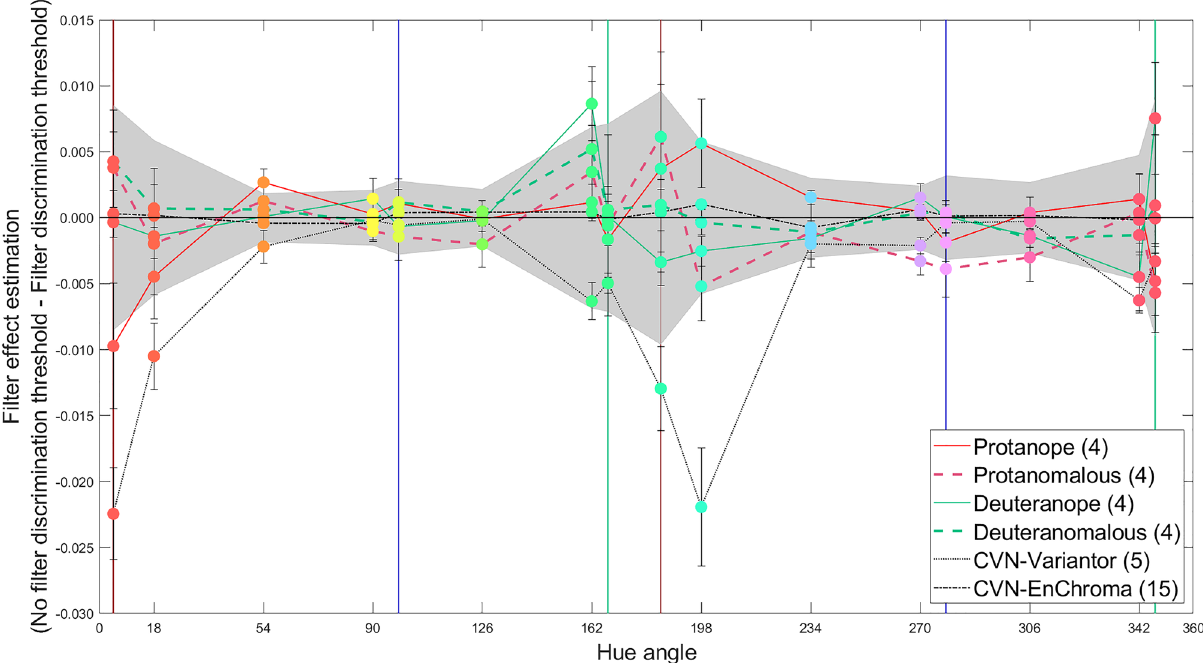
Figure 7. Mean no filter minus filter discrimination thresholds for CVA-UMinho test. Differences between no filter and filter discrimination threshold were calculated for the four CVD types using EnChroma (red solid-line for protanopia, red dashed-line for protanomaly, green solid-line for deuteranopia and green dashed-line for deuteranomaly) and for the CVN groups using Variantor (black dotted-line) and EnChroma (black dashed- dotted-line). Values above the solid horizontal black line across hues at 0 (y-axis) indicate improvements in discrimination with the filters whilst values below, indicate degradations in discrimination. The grey area indicates variance (± 1 SD) across the CVD group. Marker colours are approximations of hues presented at maximum saturation. Vertical lines represent the two extremes of the protan (red), deutan (green) or tritan (blue) confusion lines. Error bars show ± 1 standard error of the group mean pants (Supplementary Table S10 for loose criterion) and in Supplementary Table S11 for Portuguese participants (Supplementary Table S12 for loose criterion). On examining Fig. 4m–r (and Supplementary Fig. S1i–p and Supplementary Tables S9 and S11) for CVD participants, EnChroma filters only slightly changed modal hit scores for all BCTs for British and Portuguese CVD participants. Using a criterion of ≥ 3% change (much smaller than the 20% criterion used for Variantor filter effects): British CVD participants (3 Protan, 6 Deutan), made more errors in naming blue (− 6%) and improved (fewer errors) in naming brown (+ 6%) and pink (+ 5%); Portuguese CVD participants (5 Protan, 2 Deutan) made more errors in naming blue (− 4%) and pink (− 10%) and fewer errors in naming purple (+ 3%), grey (+ 6%), orange (+ 20%) and brown (+ 3%). Changes also occurred in naming for CVN participants wearing EnChroma filters (Fig. 4g–l and Supplementary Tables S5 and S9). With EnChroma filters, British CVN partici- pants made more naming errors for orange (− 5%) and purple (− 3%) and fewer errors for naming brown (+ 4%); Portuguese CVN participants made more naming errors for red (− 13%), grey (− 7%) and brown (− 3%) and fewer errors for naming blue (+ 3%) and orange (+ 7%). An additional statistical analysis on BCTs is provided in the Supplementary information. As the same hue angles were tested in both discrimination and naming tasks, specific colour naming error scores for each hue angle (modal criterion), with and without EnChroma filters are provided for CVN and CVD groups in Fig. 5b,c. These data were analysed using a three-way mixed-measures ANOVA with filter (no-filter, EnChroma) and hue (16 hues tested) as within-subjects factors, and participant group (CVN, CVD) as the between-group factor. There was a significant effect of hue on naming hit scores ( F (5.07,146.96) = 13.48, P < 0.001, η 2 = 0.32) and a significant effect of participant group on them ( F (1,29) = 71.88, P < 0.001, η 2 = 0.71). However, there was no significant overall effect of filter ( P = 0.557) and no significant interaction between filter and participant group ( P = 0.905). In summary, colour naming for the CVD group was significantly worse than for the CVN group across all hues but EnChroma filters had no significant impact on colour naming for CVN, or CVD participants (Fig. 5b,c), which is in line with their lack of impact on colour discrimination thresholds (seen in Fig. 3b,c). CVN participants showed improvements (reductions in naming errors by ≥ + 3%) with EnChroma for 98.5° (tritan axis) and 198°. CVN participants increased naming errors (by ≥ − 3%) at 167.3° and 347.3° (deutan axes) and 306°. CVD participants showed improvements with EnChroma (≥ + 3%) for 18°, 54°, 98.5 (tritan axis) and 306°, but increased naming errors (≥ − 3%) for 126°, 162°, 184.66° (protan axis), 198°, and 347.5° (deutan axis). Additional analyses on BCTs and on differences in hit-scores (i.e., no-filter minus filter) are provided in the Supplementary information.